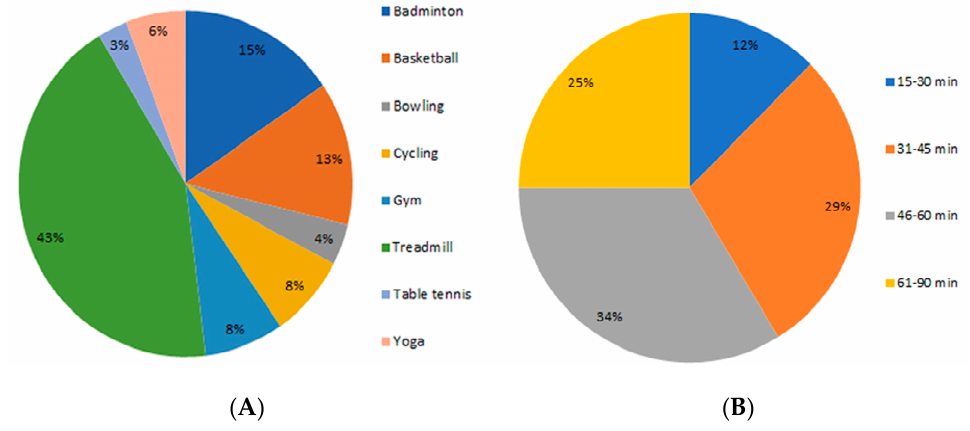
Figure 1. Distribution of 104 candidates according to ( A ) type of exercise and ( B ) duration of exercise.